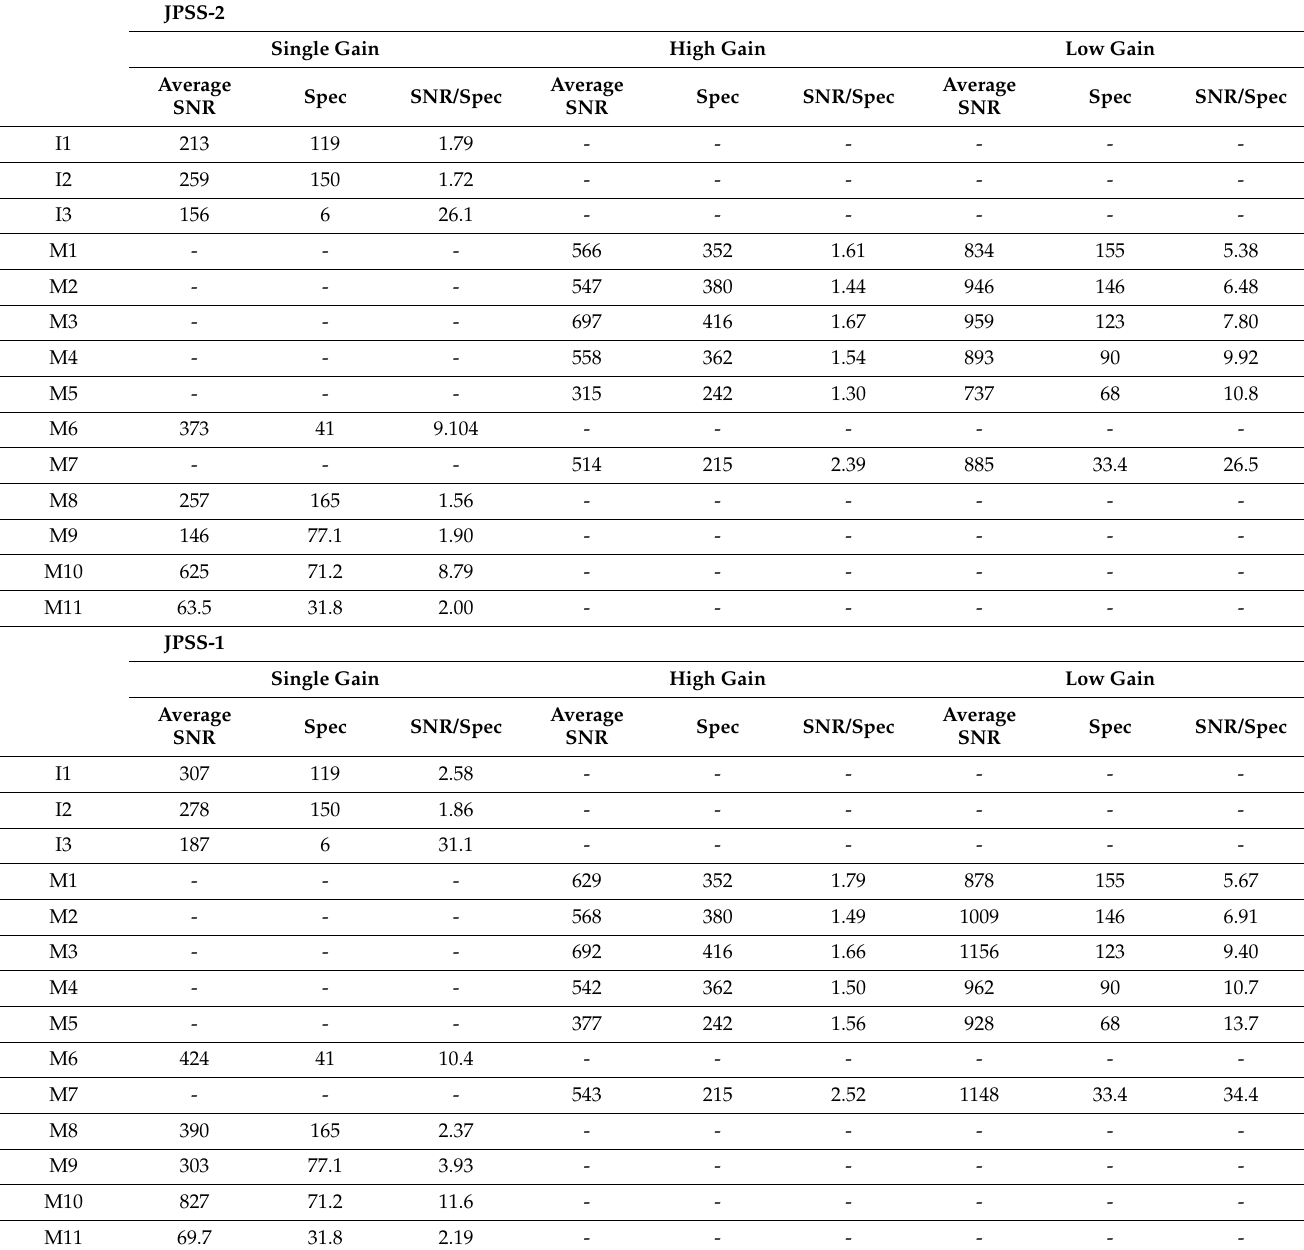
Table 4. Signal-to-noise ratio (SNR) results for the VIIRS reflective solar bands. The SNR, SNR requirement and the ratio of the two are shown here. The top portion is for JPSS-2 and the bottom JPSS-1 for comparison